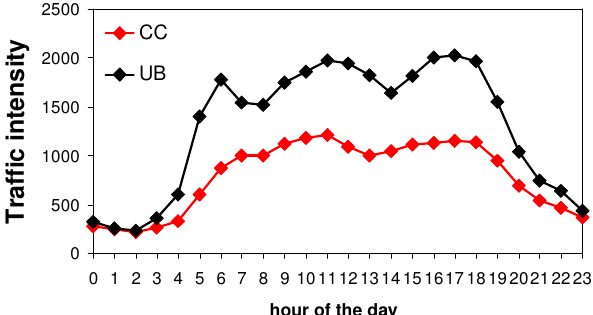
Fig. 3. Mean daily cycles of number of vehicles at UB (Diagonal Ave.) and CC (Parallel Ave.) measurement